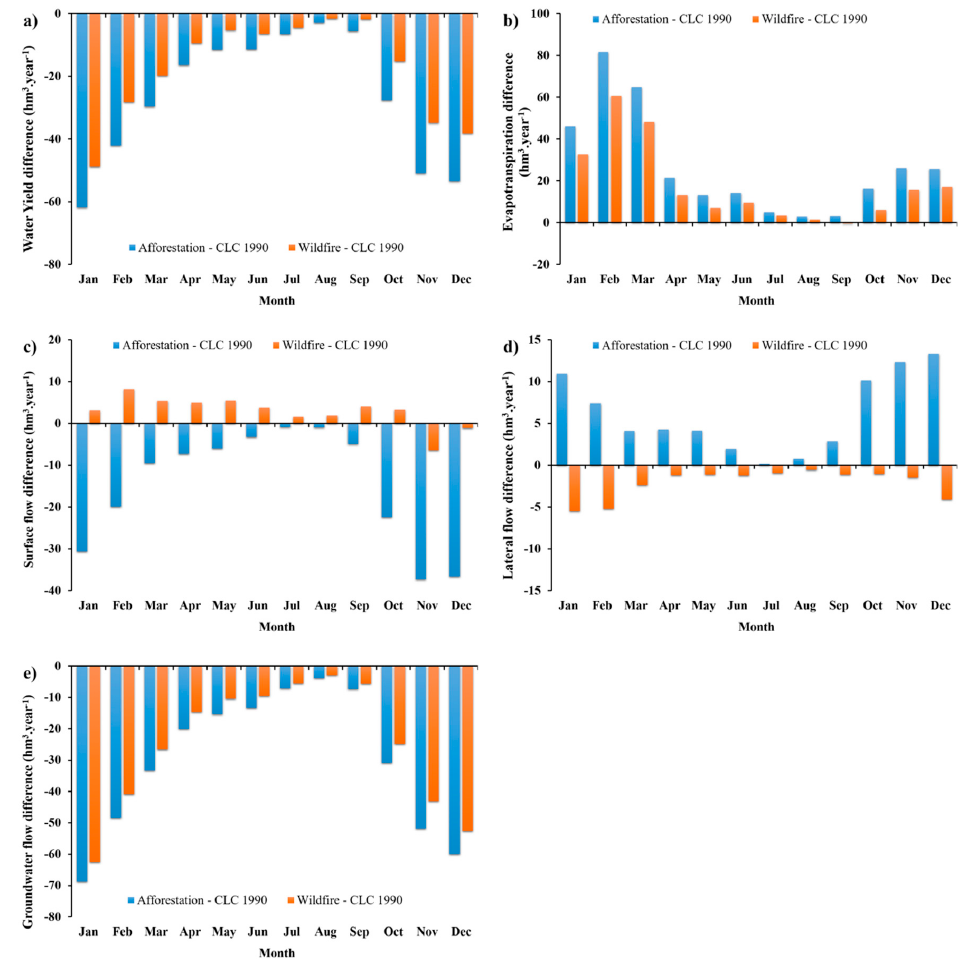
Figure 10. Quantity of water (hm 3 ·year − 1 ) ( a ) in the water yield; ( b ) in evapotranspiration; ( c ) in surface flow; ( d ) in lateral flow; and ( e ) in groundwater flow. The blue bars show the difference between the reference model and the afforestation scenario model, and the orange bars show the difference between the reference model and the wildfires scenario model.